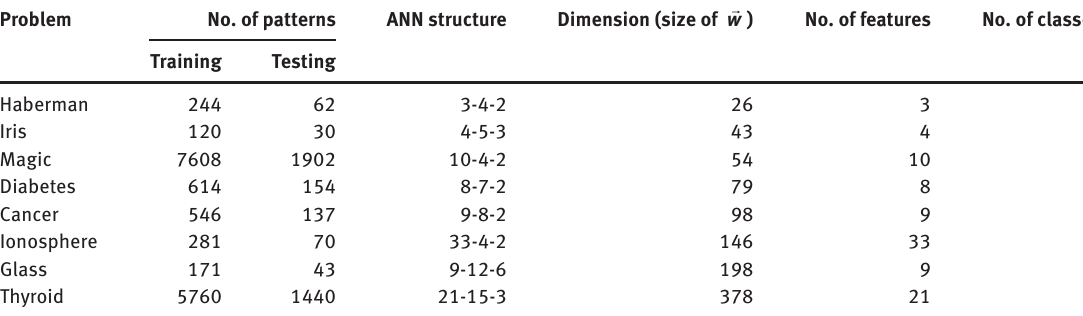
Table 3: Benchmark Classification